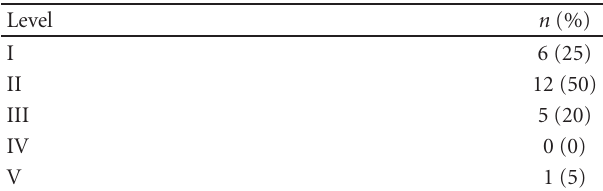
Table 3: Patterns of cervical lymph node